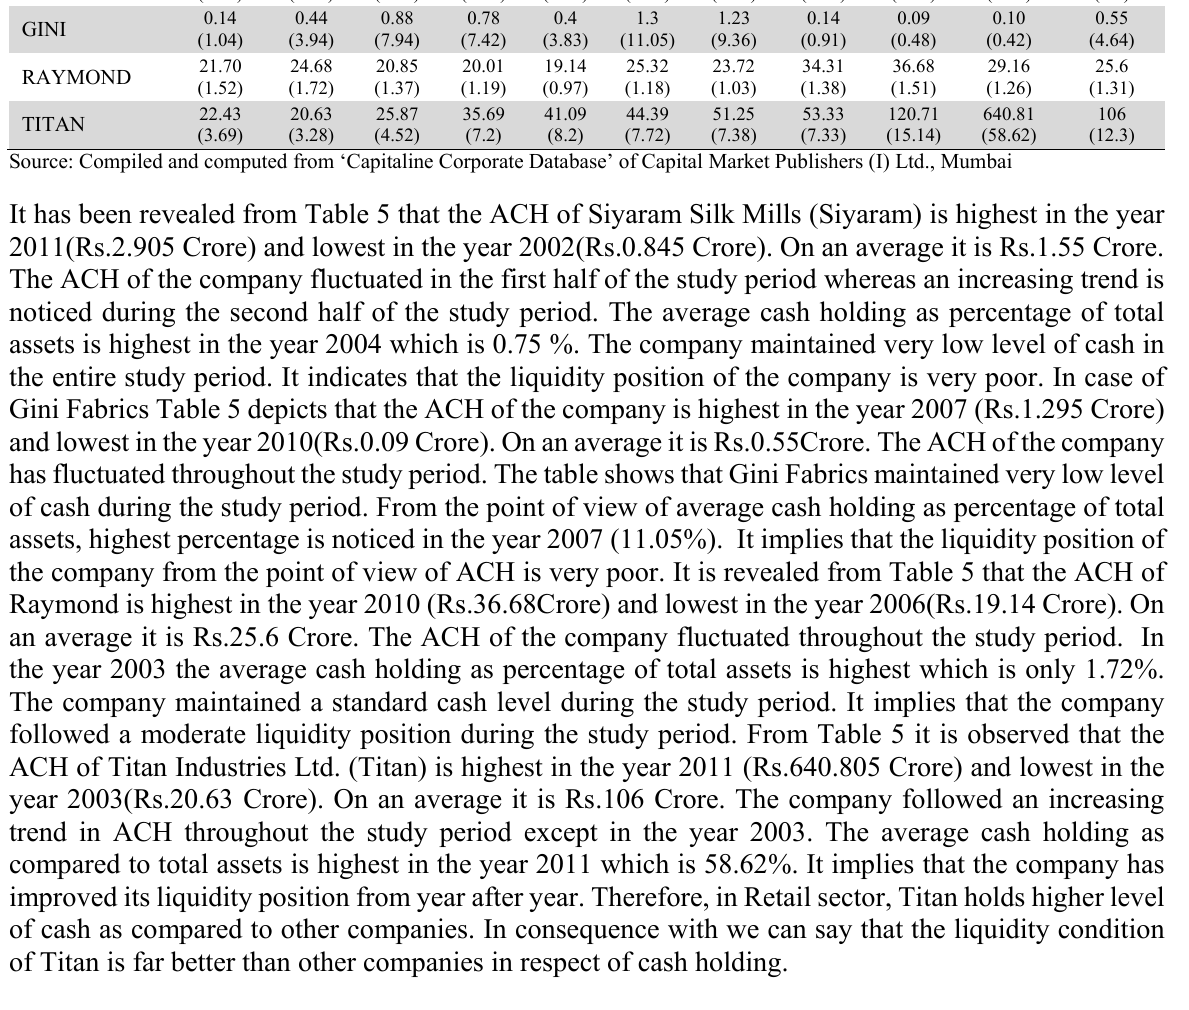
Analysis of Average Cash Holding (Avg. Cash Holding as percentage of total assets) of Selected Companies of Retail sector COMPANIES